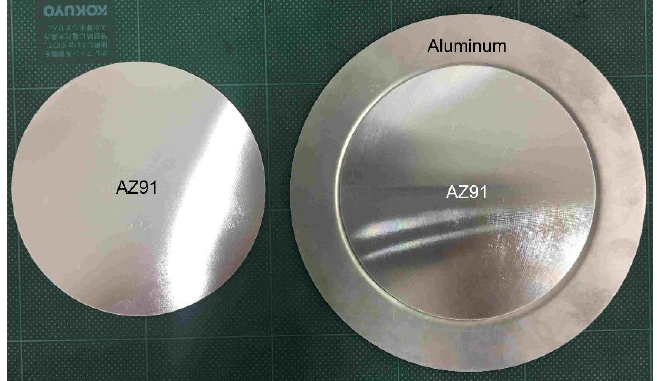
Figure 18. AZ91 plate and an auxiliary plate composed of aluminum alloy.